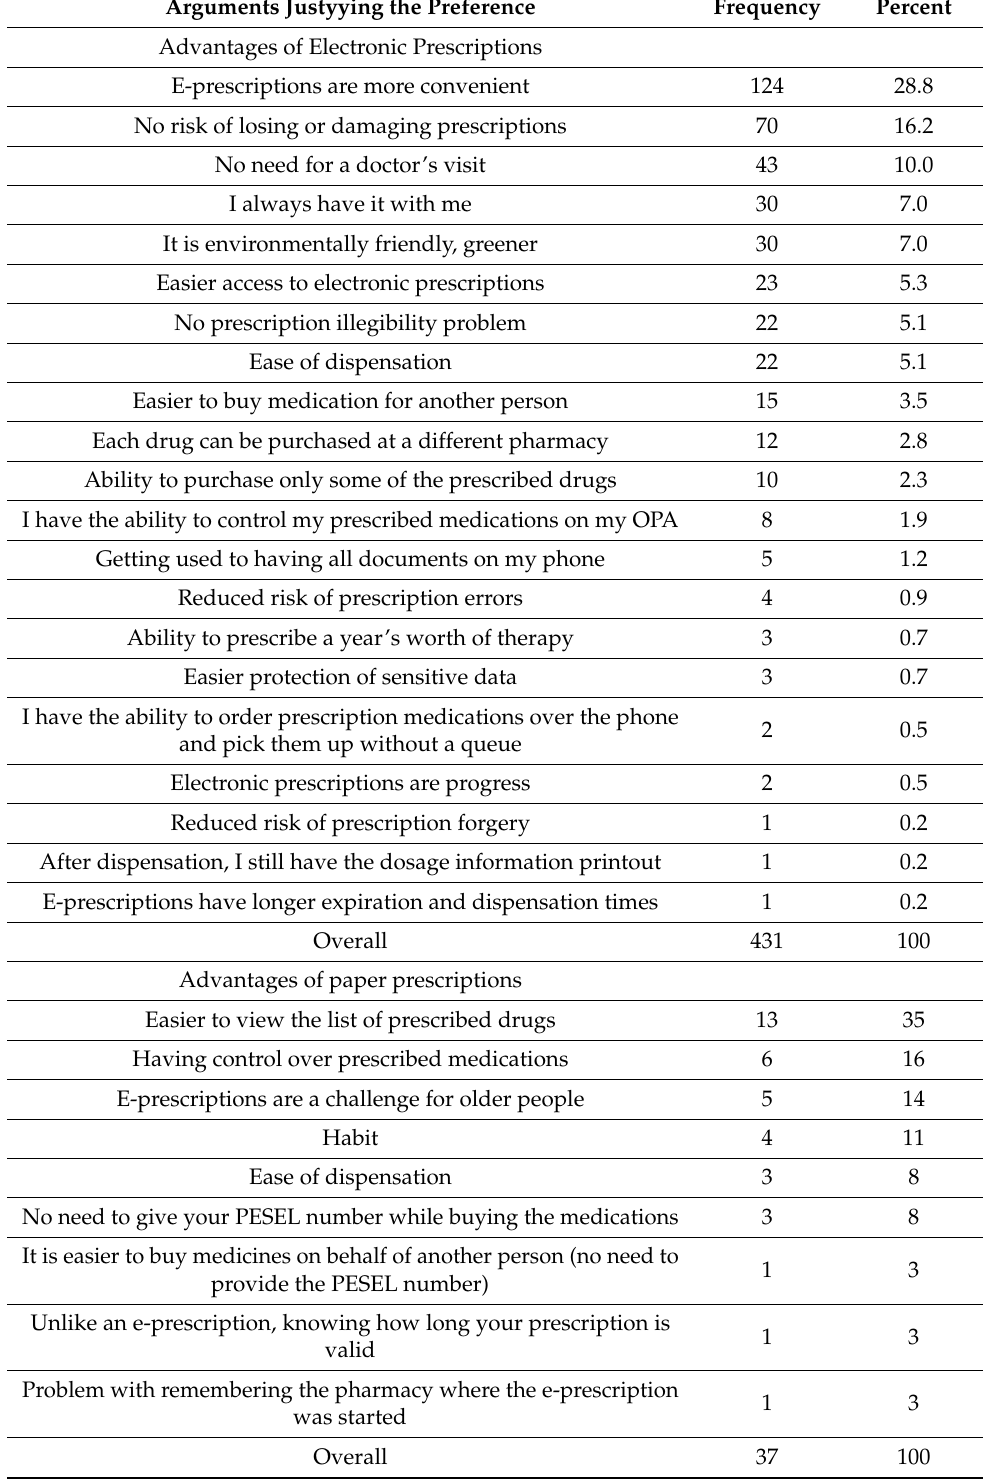
Table 4. Summary of arguments justifying the preference for the form of prescription